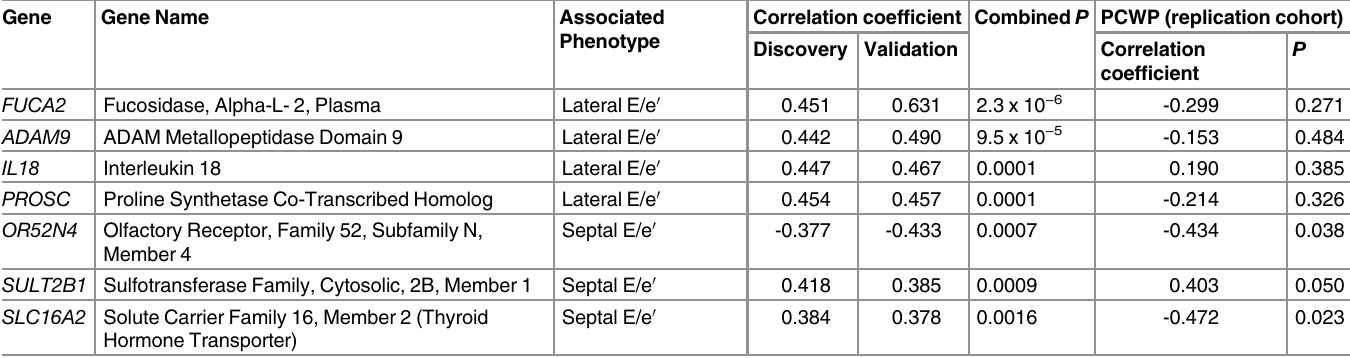
Table 2. Candidate genes associated with diastolic function in SCD discovery and replication